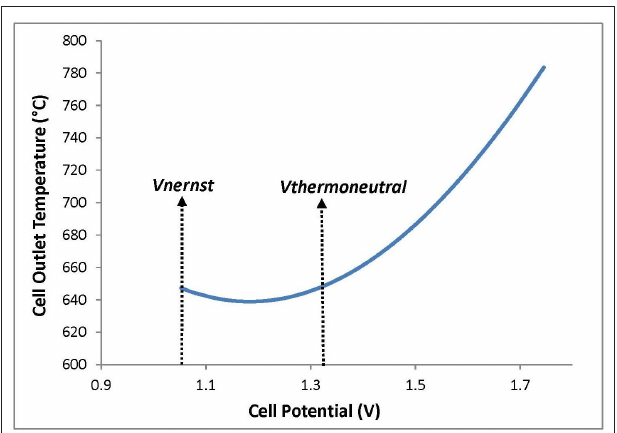
FIGURE 3 | Effect of the cell potential on the outlet temperature of the cell streams during electrolysis cell